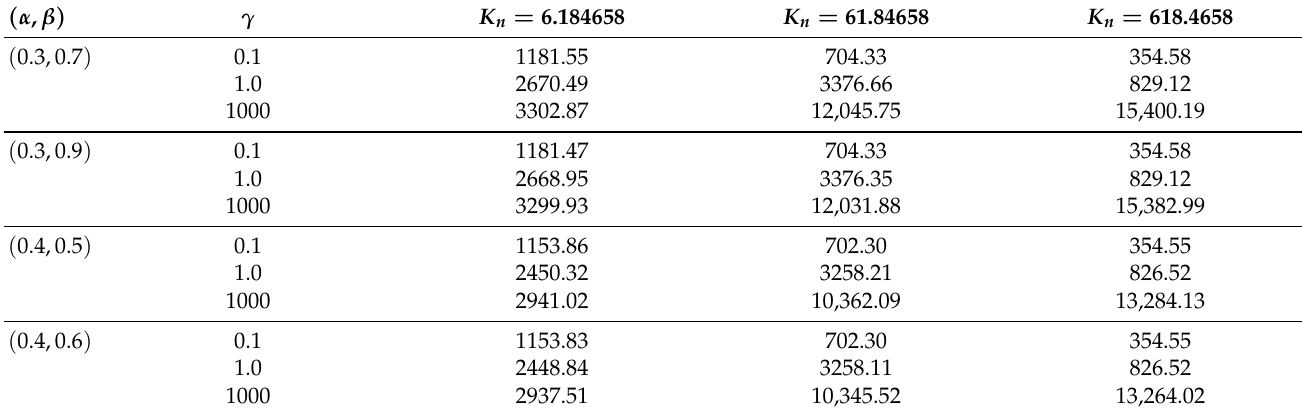
Table 12. ( T e ) max with different K n , γ , α and β ( α < β ) for Example 2.